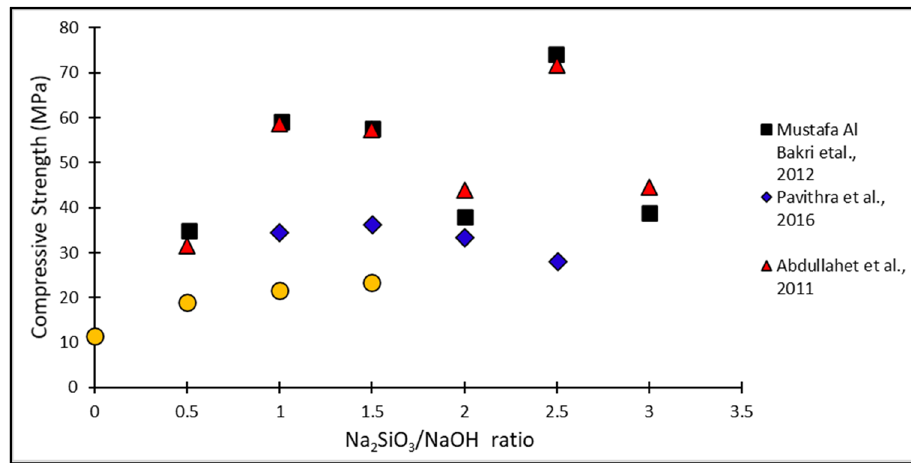
Figure 5: Graph compiling compressive strength data vs Na 2 SiO 3 /NaOH ratio obtained from previous investigations ( 80 – 82 )